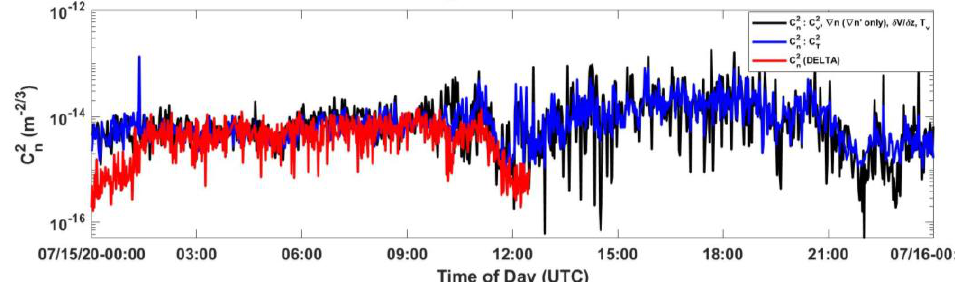
Figure 11. Profiles of 𝐶 𝑛2 at 24.5 above the surface using in situ sonic anemometer measurements Figure 11. Profiles of C 2 n at 24.5 above the surface using in situ sonic anemometer measurements 𝜕〈𝑽〉 (derived from 𝐶 𝑉2 , ∇〈𝑛 ′ 〉, , mean = 1.2 × 10 − 14 , std dev = 1.6 × 10 −14 ) as well as the DELTA system (derived from C 2 , (cid:104) ∇ n (cid:48) (cid:105) , ∂ (cid:104) V (cid:105) , mean = 1.2 × 10 − 14 , std dev = 1.6 × 10 − 14 ) as well as the DELTA 𝜕𝑧 V ∂ z (mean = 4.6 × 10 −15 , std dev = 3.0 × 10 −15 ) on 15 July 2021; DELTA measurements were not available system (mean = 4.6 × 10 − 15 , std dev = 3.0 × 10 − 15 ) on 15 July 2021; DELTA measurements were not after 1200UTC. For comparison, a profile of 𝐶 𝑛2 at 24.5 m, as derived from 𝐶 𝑇2 (mean = 1.0 × 10 −14 , available after 1200UTC. For comparison, a profile of C 2 n at 24.5 m, as derived from C 2 std dev = 1.1 × 10 −14 ) on 15 July 20 at Wright-Patterson AFB. 10 − 14 , std dev = 1.1 × 10 − 14 ) on 15 July 20 at Wright-Patterson